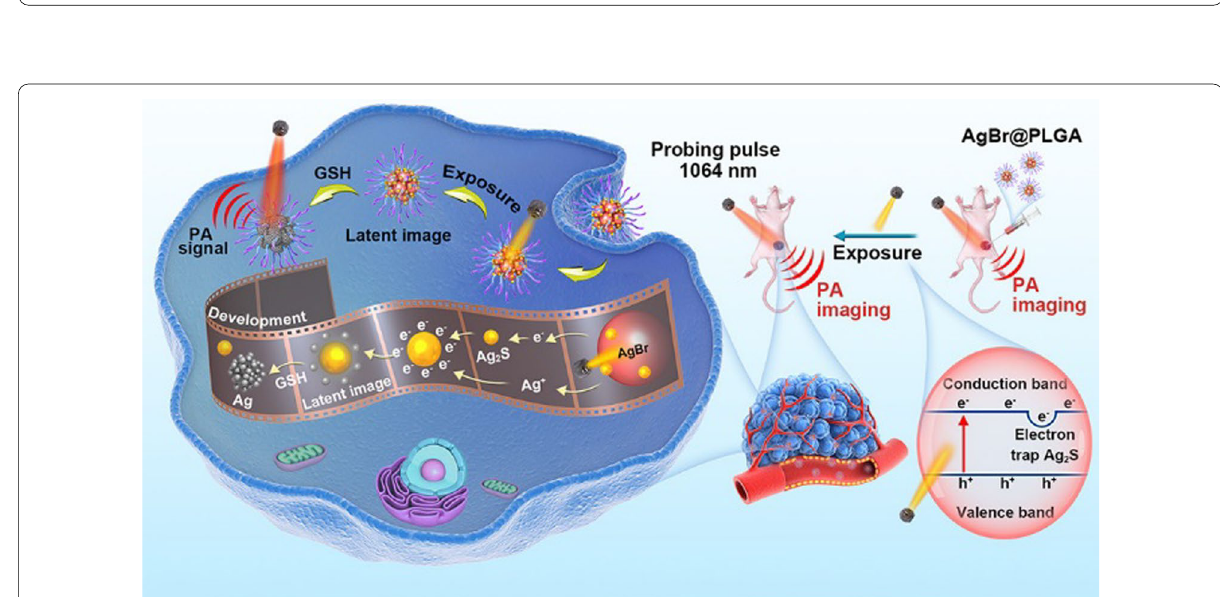
Fig. 7 Synthesis process of the prepared AgBr@PLGA NCs and the schematic illustration that tumor area is graphically fixed via redox reaction where the NIR-transparent AgBr@PLGA NCs can be reduced by the tumor-abundant GSH into strongly absorbing silver NPs. Adapted from Ref. [122] with permission. Copyright (2021), ACS